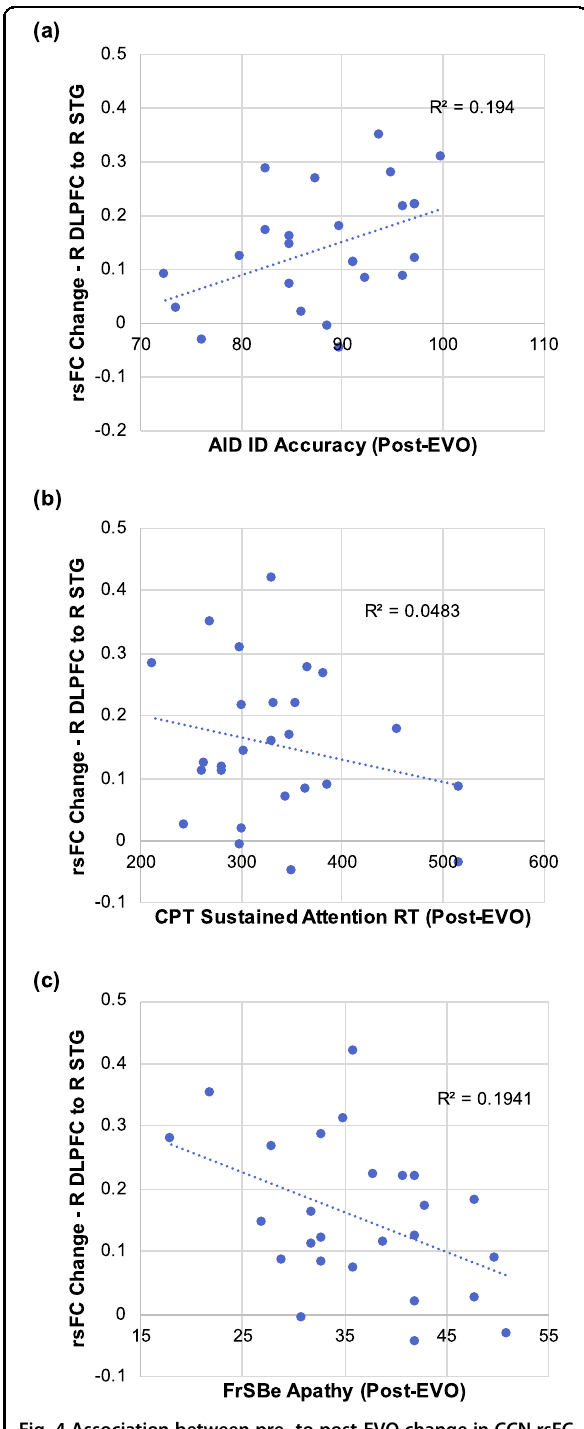
Fig. 4 Association between pre- to post-EVO change in CCN rsFC is and cognitive control performance and self-reported symptoms post-EVO. a Change in rsFC between the R MFG and R STG is signi fi cantly correlated with accuracy on the “ Ignore distractor ” condition of the AID task post-EVO. b Change in rsFC between the R MFG and R STG is signi fi cantly not correlated with performance on the “ Sustained Attention ” condition of the CPT post-EVO. c Change in rsFC between the R MFG and R STG is signi fi cantly correlated with post-intervention scores on the Apathy Subscale score of the FrSBe self-report